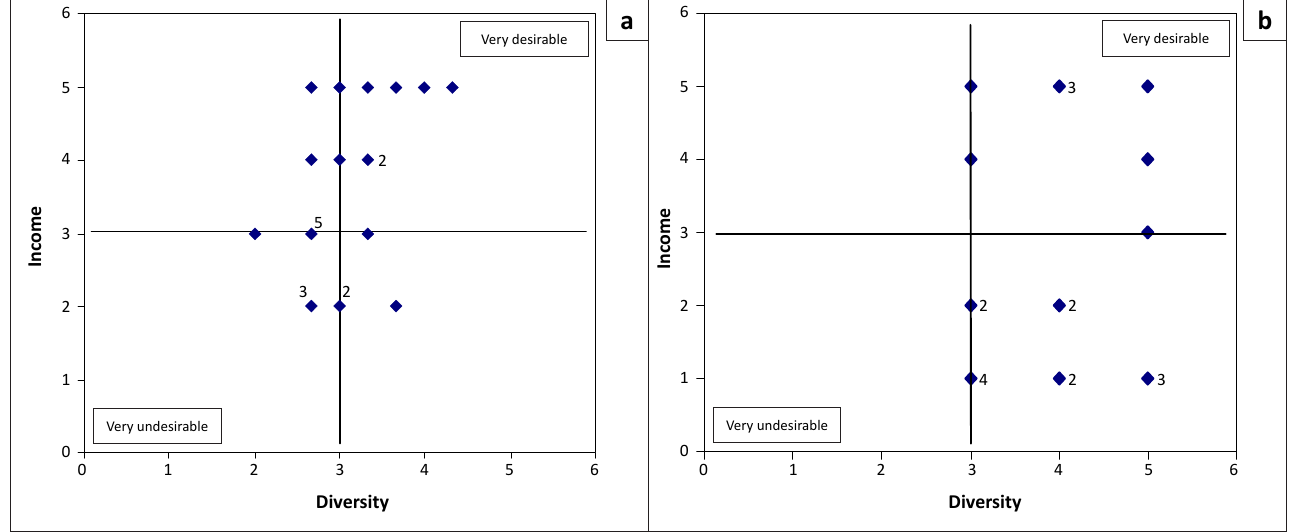
FIGURE 3: Indices of potential income based on (a) product versus vegetation condition parameters and herbivore biodiversity for the private protected areas and (b) on bed nights sold per area (km 2 ) per year versus biodiversity parameters (as shown in Table 2). Number next to point indicates number of properties or parks represented with this index where more than one falls into the specific category. TABLE 1: Indices for biodiversity and income derived for the private protected areas (also see Figure 3a). Protected areas